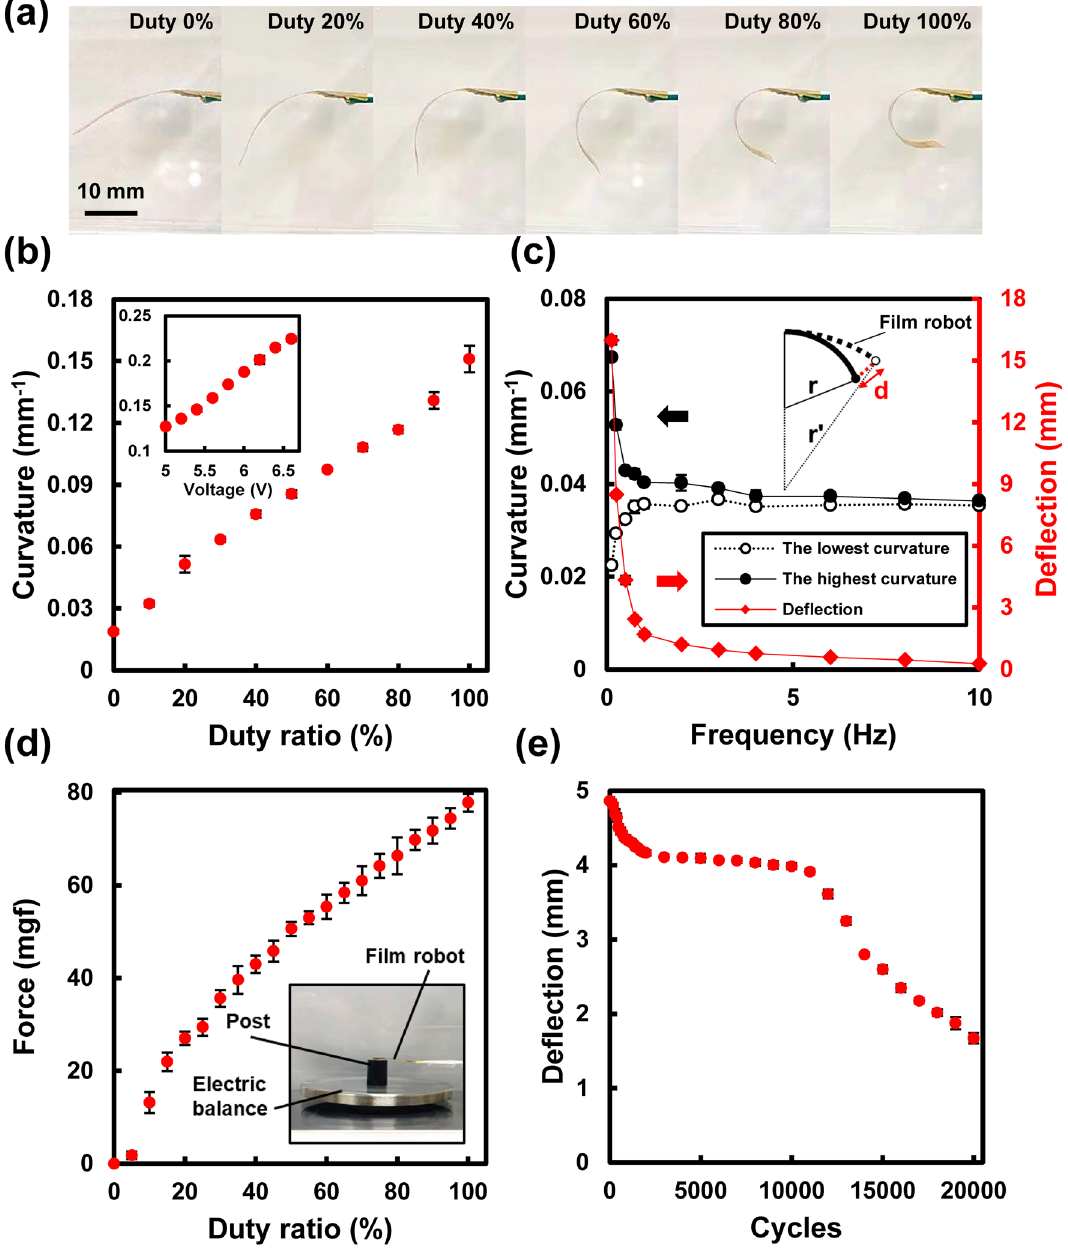
Figure 3. Actuation characteristics with single-finger film microrobot. ( a ) Photograph of robot actuation with different duty ratios with a 5 V PWM power supply. ( b ) Dependency of curvature on supplied power (5 V PWM) and on DC voltage change at 100% duty ratio (inset). ( c ) Frequency response of actuator deformation shown as minimum and maximum curvature on the amplitude (left axis) and tip deflection (right axis). ( d ) Generated force at zero deflection point. and photograph of measurement setup (inset). ( e ) Repetitive actuation durability of the robot on 20,000 bending motions. Bars represent standard deviation (n =